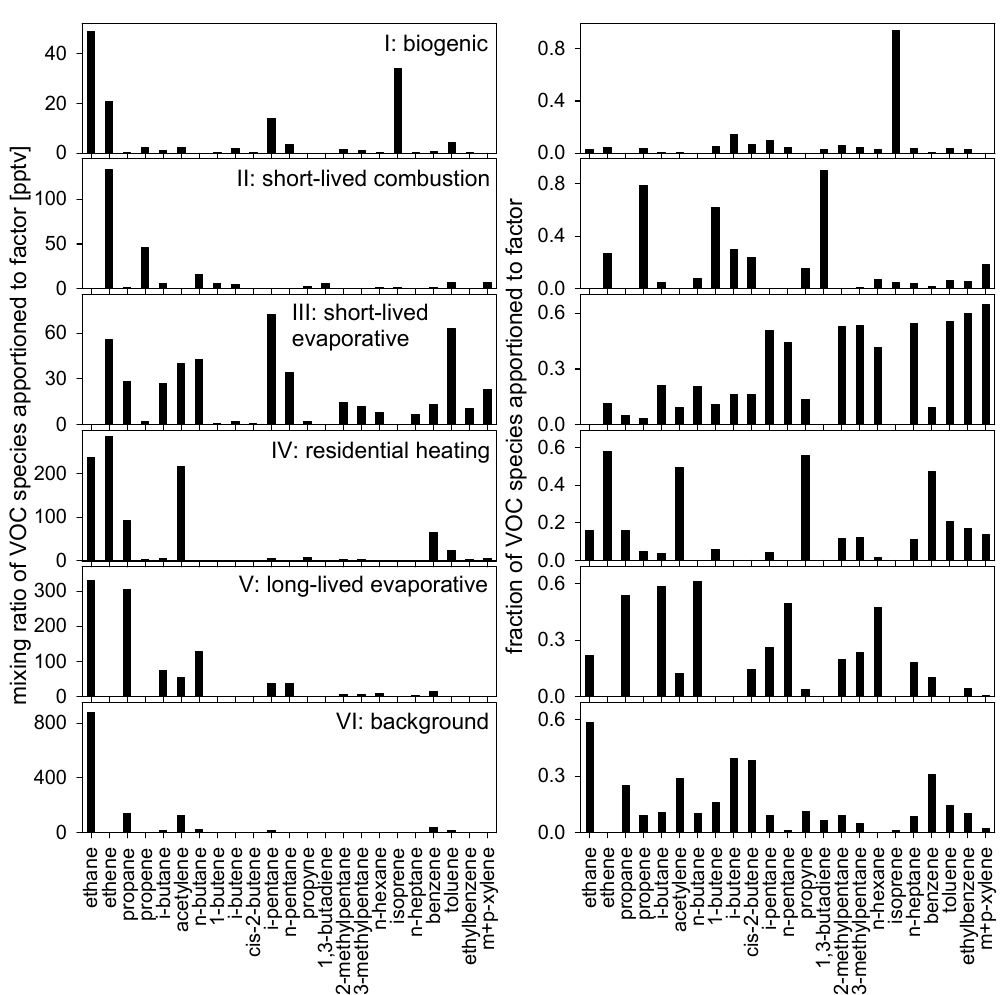
Figure 3. Factor profiles for the six-factor solution calculated by PMF. Left: mixing ratio of each species apportioned to each factor (pptv); right: contribution of each factor to the species. Note that the scales for each subplot are different due to large variations in absolute mixing